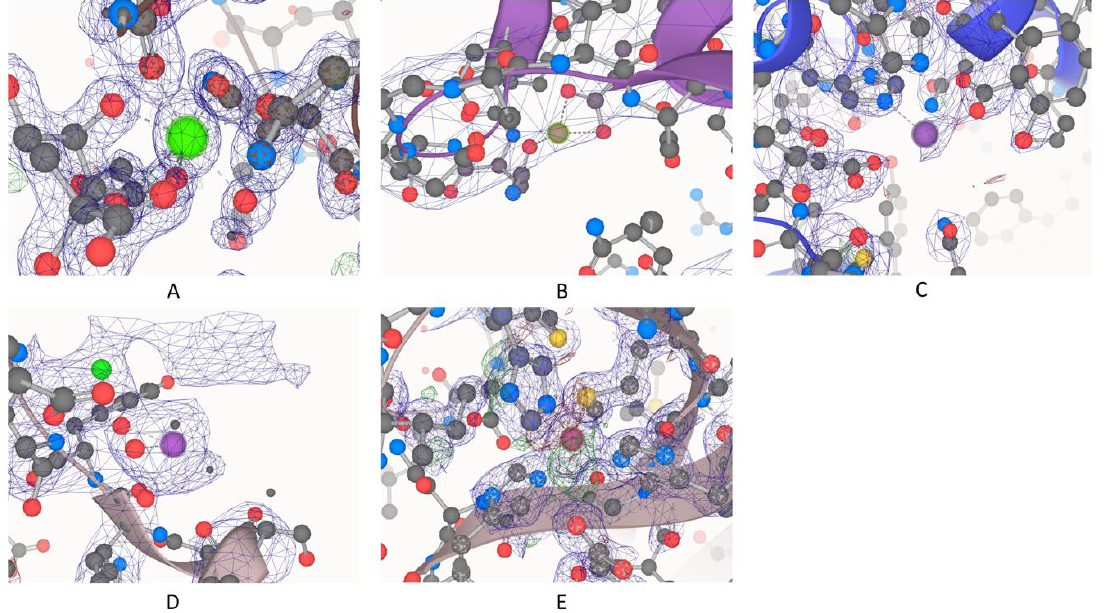
Figure 1. High- and low-quality examples for all four criteria: ( A ) Protein Data Bank (PDB) ID: 5FVN.F.405.CA, representative of high quality by passing all four criteria; ( B ) PDB ID: 1YV0.C.163.MG, resolution: 7 Å ; ( C ) PDB ID: 3CIA.B.701.ZN, occupancy: 0.7; ( D ) PDB ID: 5ER8.A.706.MN, symmetry atoms nearby; ( E ) PDB ID: 3LZQ.A.200.CU, high discrepancy between calculated and observed electron density maps.